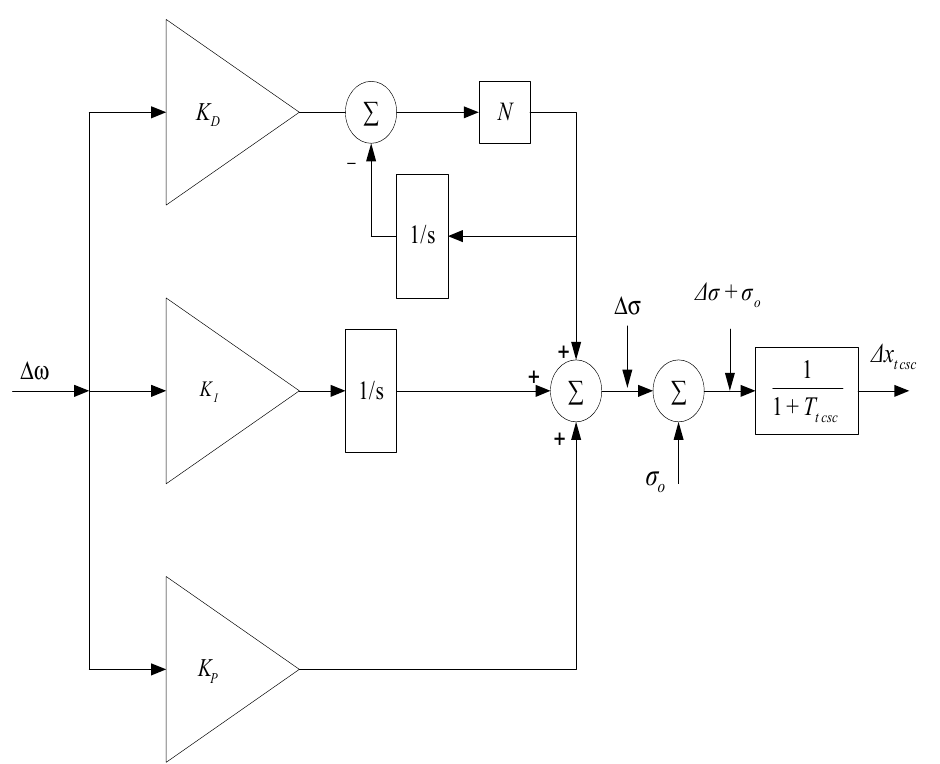
Figure 3. Block diagram of the PIDF controller. A block diagram of the TCSC PIDF controller with a speed deviation in the SMIB system is shown in Figure 4.